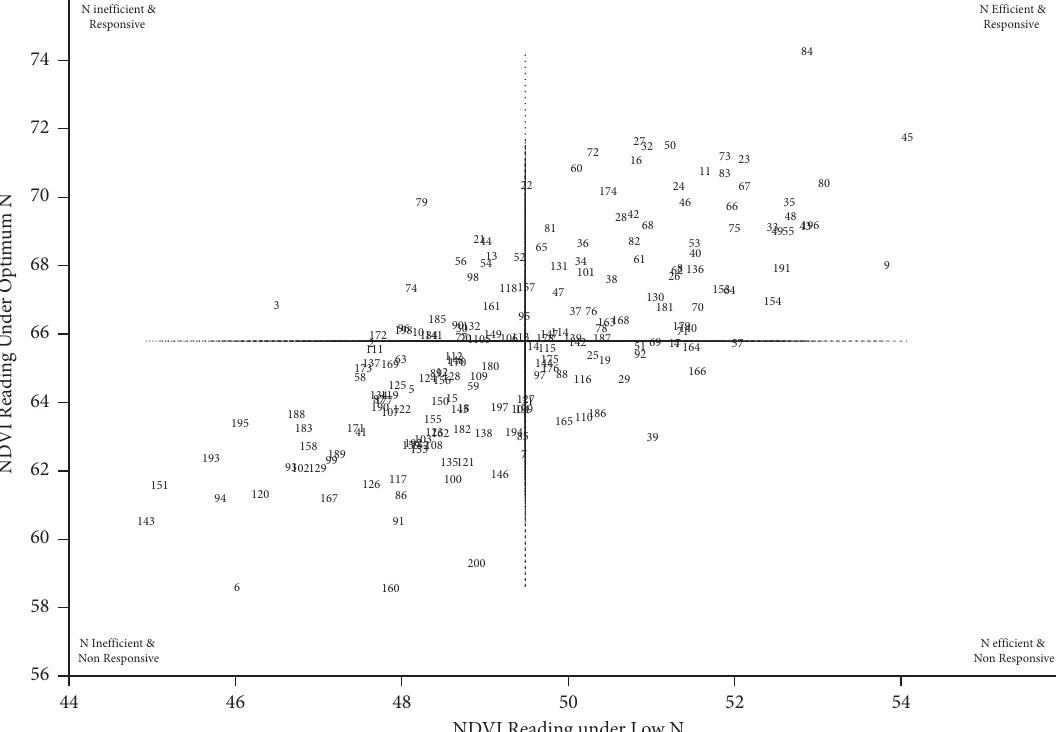
Figure 5: Categorization of N-efcient and N-responsive durum wheat genotypes based on NDVI reading. Horizontal and vertical broken lines depict mean NDVI values under low and optimum N conditions, respectively.